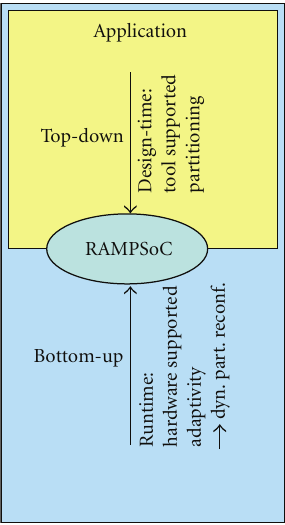
Figure 4: “Meet in the middle” Designflow approach for RAMP-